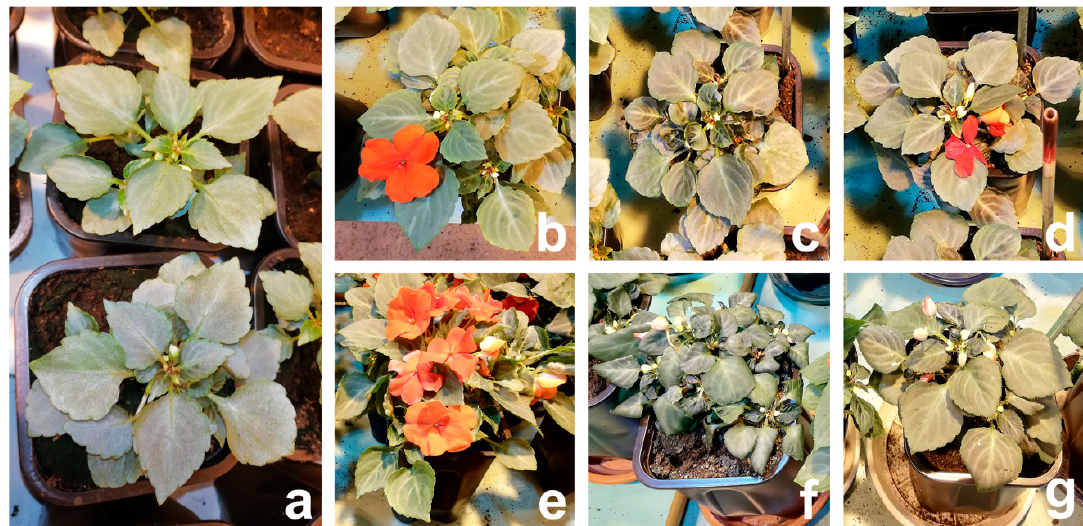
Figure 3. Morphological differences between I. walleriana at “start point“ of drought stress imposition ( a ); 15% of soil moisture content—control ( b ), drought-stressed ( c ) and recovered plants ( d ), and at 5% of soil moisture content—control ( e ), drought-stressed ( f ) and recovered plants ( g ).